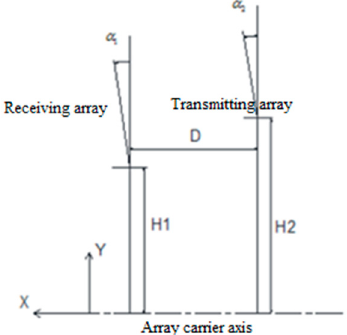
Figure 20. Configuration Model of Bistatic Array.